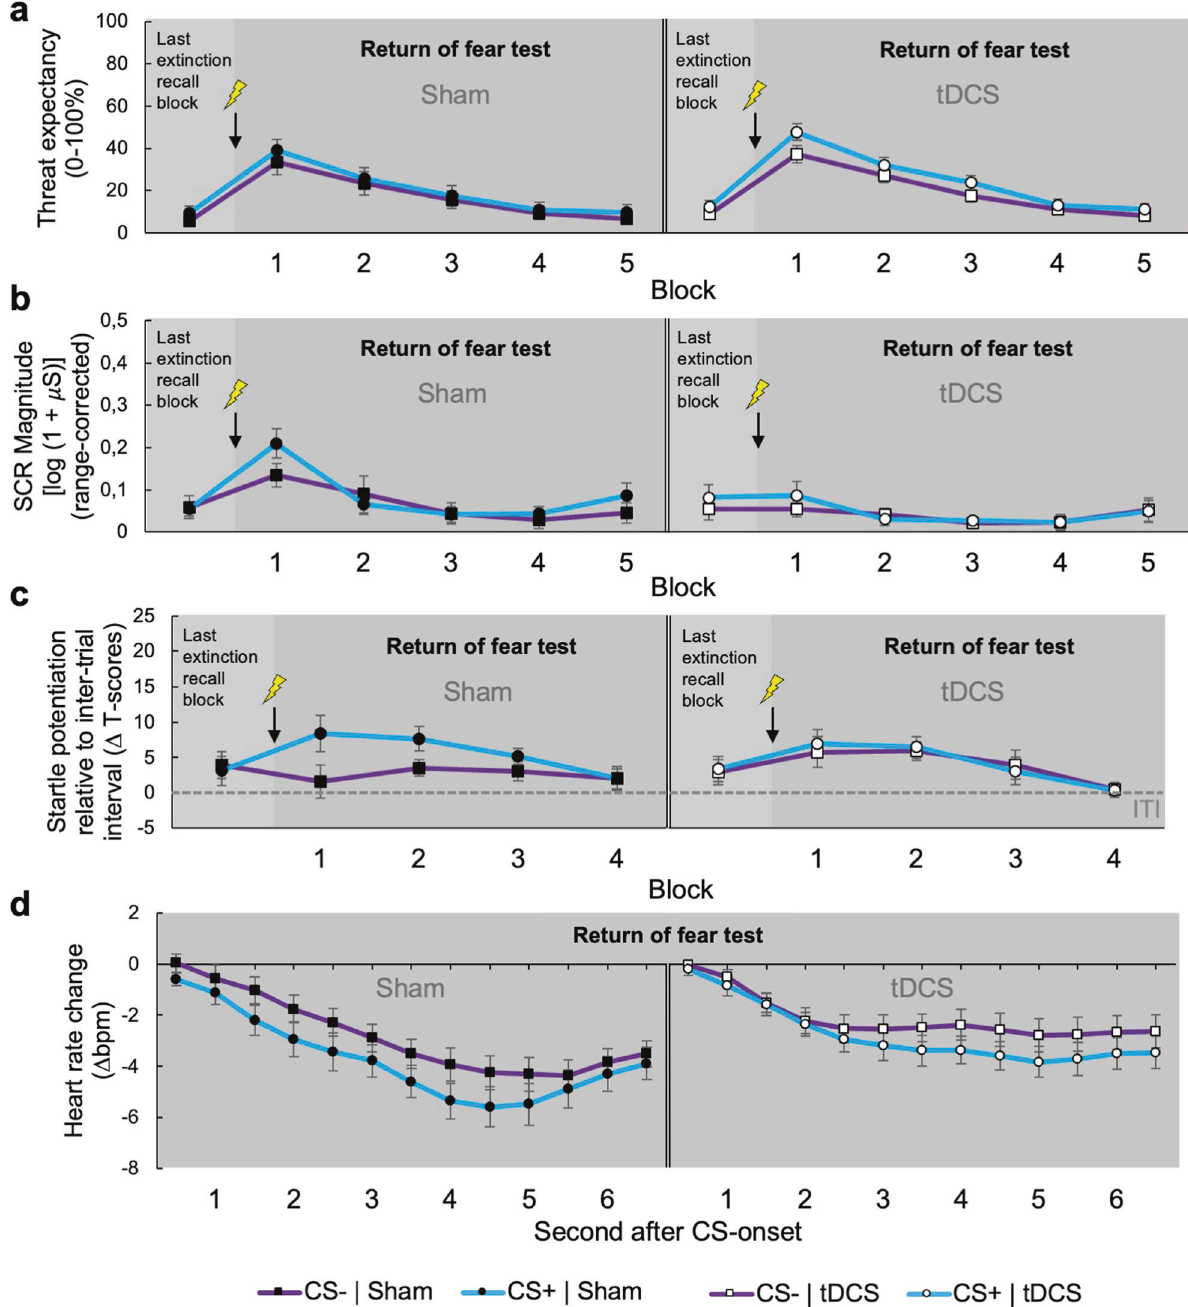
Fig. 5 Day 2: Transcranial direct current stimulation targeting the vmPFC during extinction recall blocks the return subcortically mediated fear responses. Overall mean US-expectancy ratings ( a ), range-corrected fi rst interval skin conductance responses ( b ), standardized (T-transformed) startle potentiation relative to inter-trial interval ( c ) and heart rate change ( d ) during the CS + (blue lines) vs. the CS − (purple lines) during the last block of extinction recall and return of fear test for the sham (left panels) and tDCS condition (right panels). US- expectancy, skin conductance and startle potentiation are averaged across blocks of two trials, while heart rate change is averaged across all trials of the return of fear test. Error bars represent the standard error of the mean. The bolt-icon represents repeated (three times) administration of the US at the beginning of the return of fear